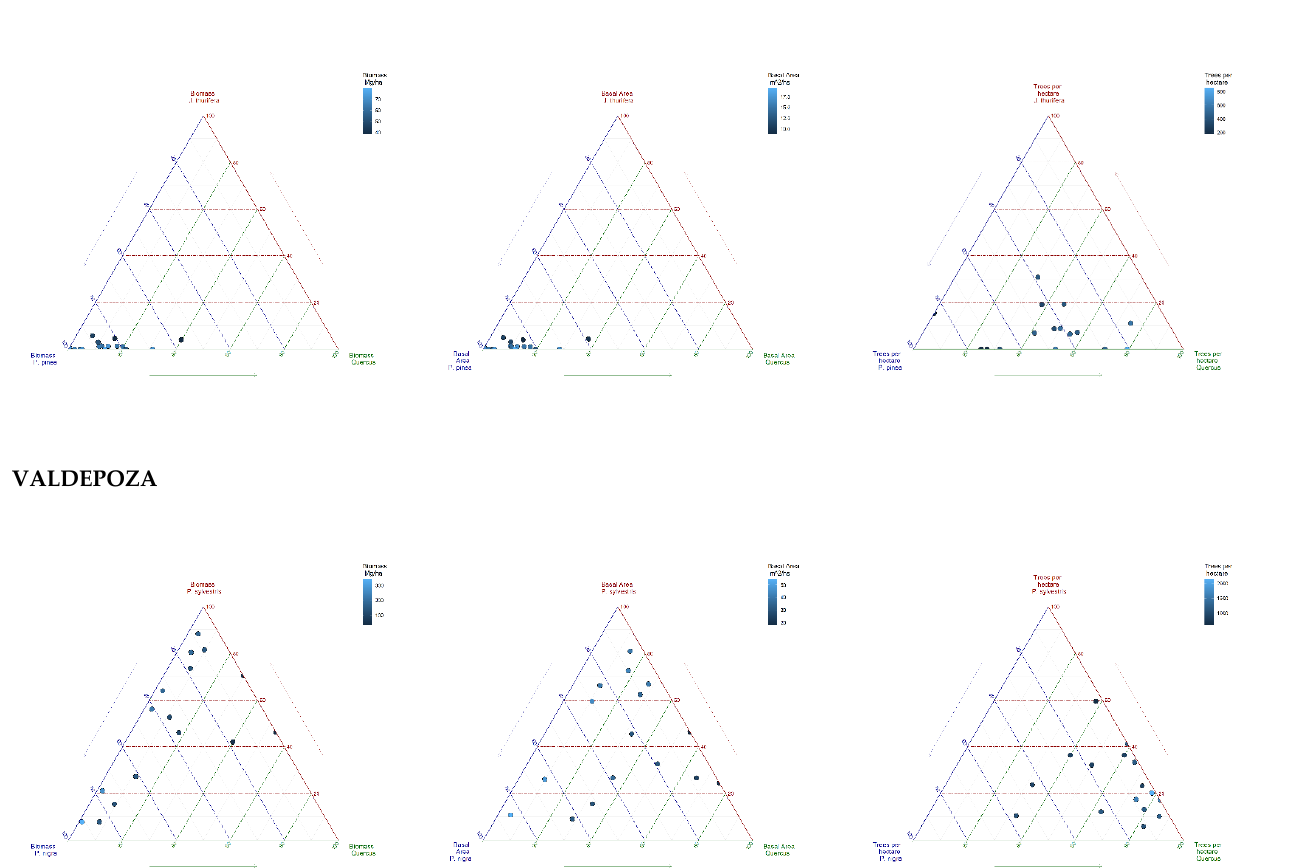
Figure 2. Ternary diagrams (ggtern package, [24]) representing the percentage of species mixture in terms of biomass, basal area, and number of trees per hectare. The representation in the axis is the identity of the species within the marteloscope: Pinus pinea , Juniperus thurifera , Quercus (mixture of Quercus ilex and Quercus faginea ), Pinus sylvestris , Quercus pyrenaica and Pinus nigra . Color of each of the points (quadrats) corresponds to biomass (Mg/ha), basal area (m2/ha) and number of trees per hectare, according to the legend.